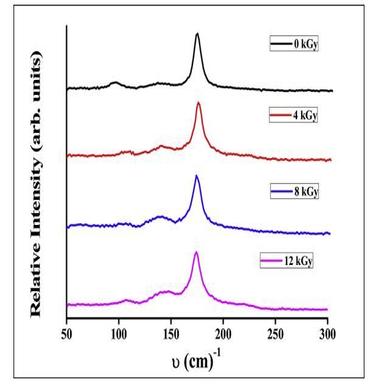
Raman spectra of the unexposed and exposed samples of STS ChGA.